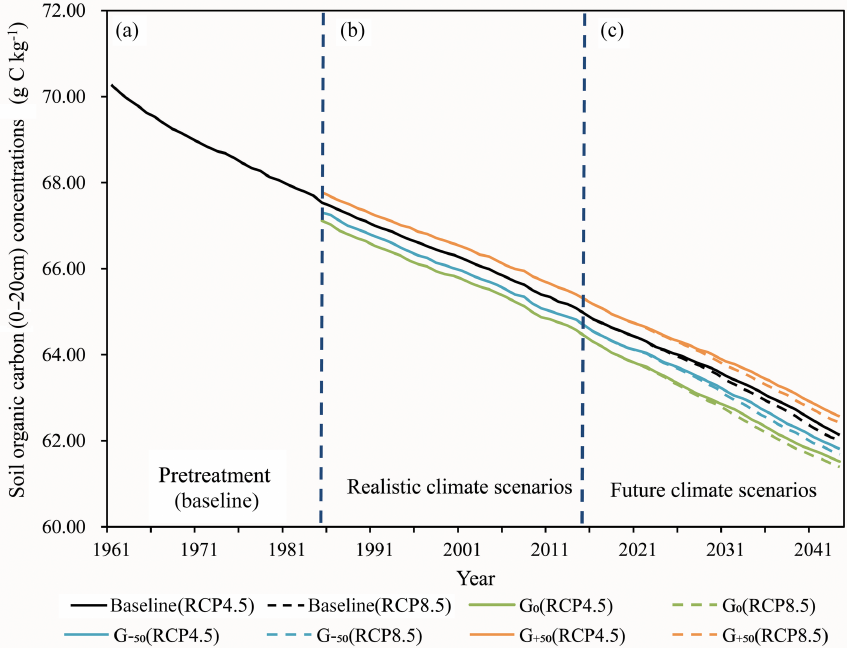
Figure 6. Variations in the area-weighted mean SOC value under different scenarios. Section (a) represents the preprocessing period from 1961 to 1984. Section (b) represents the realistic climate scenarios. Section (c) represents future climate scenarios. Table 4. Multiple linear regression analysis of grassland biomass and SOC change with relative factors. Variables R 2 PRESS Temperature Precipitation Grazing numbers intensity Biomass 1 26. 4 273067.7 X 1 6.4 370402.4 X